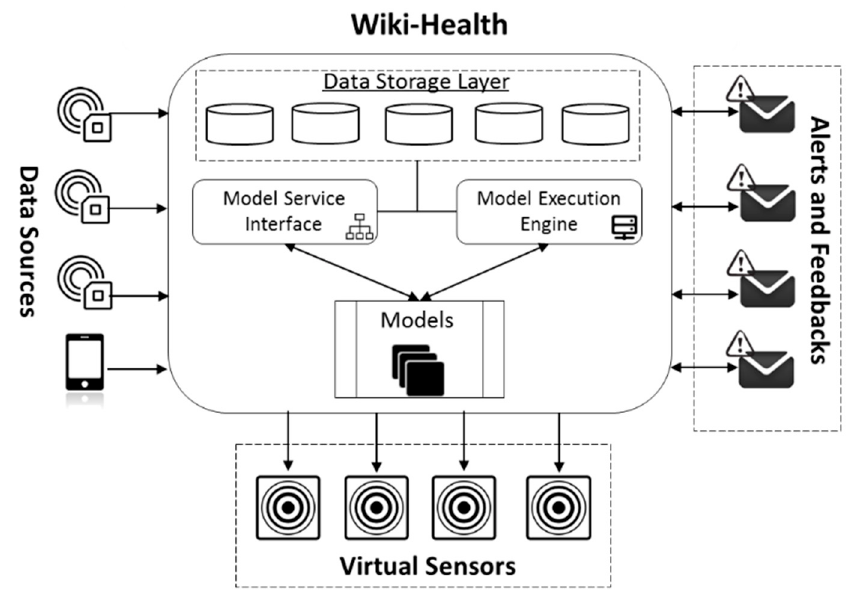
Figure 4. The proposed implementation of virtual sensors on Wiki-Health.